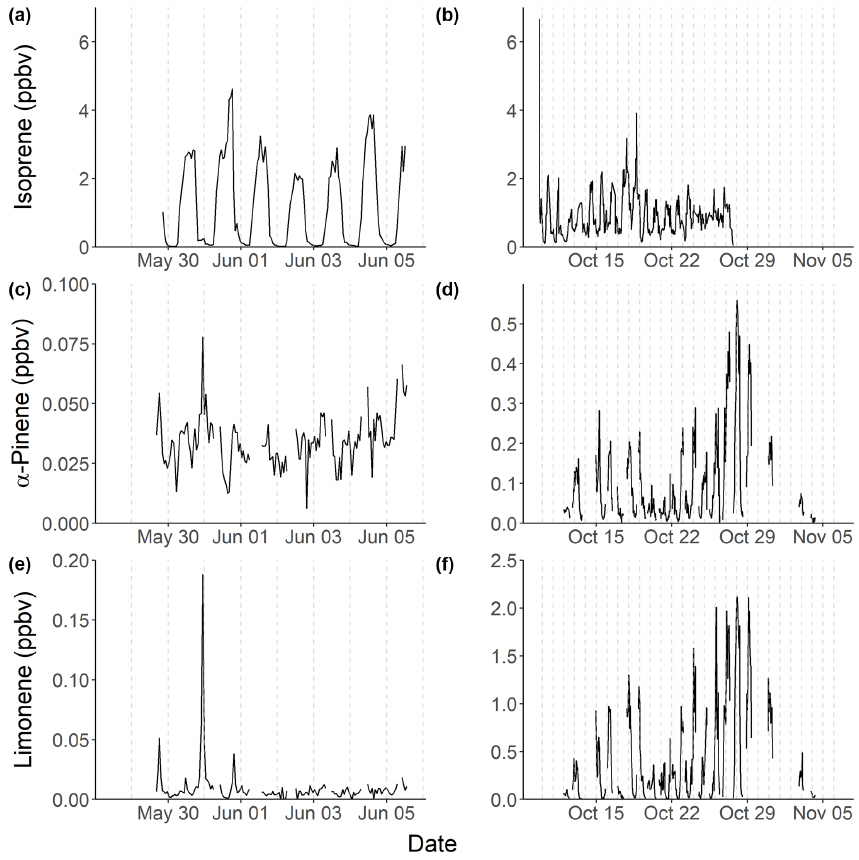
Figure 2. Time series across the pre- (a, c, e) and post-monsoon (b, d, f) campaigns of isoprene (a, b) , α -pinene (c, d) , and limonene (d, e) . The vertical dotted lines represent midnight for each